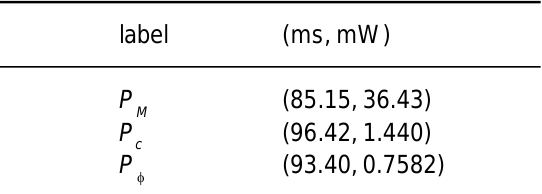
Table 1 . Numerical data read from Fig. 2. P for the largest recorded power, while P the corresponding values of the power recorded at states c and  , respectively.